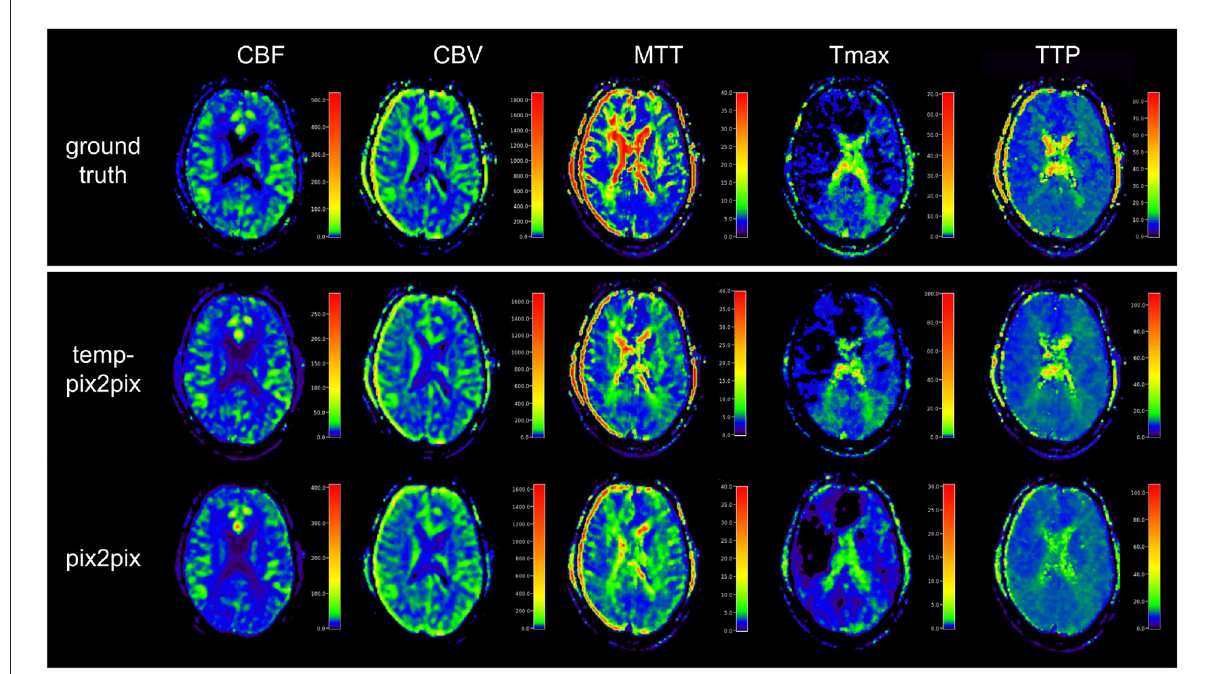
FIGURE6 Synthesized perfusion parameter maps (middle, bottom rows) compared with the ground truth reviewed by an expert (top row) for one representative patient showing average performances from the PEGASUS test dataset. Both pix2pix and temp-pix2pix GAN synthesized most parameter maps that resemble the ground truth. Parts of MTT were not entirely captured by pix2pix and temp-pix2pix. Moreover, the pix2pix GAN did not synthesize the higher intensities of Tmax well. For MTT and Tmax, the temp-pix2pix GAN showed better performance in all metrics compared with the pix2pix